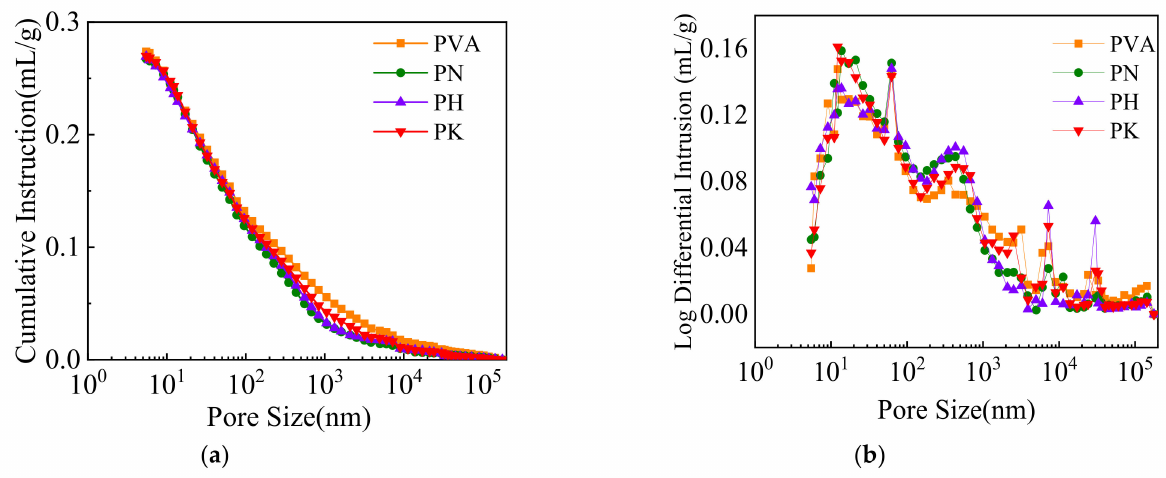
Figure 13. Pore structure of the specimens with 1% fiber content: ( a ) cumulative pore volume, ( b ) pore size